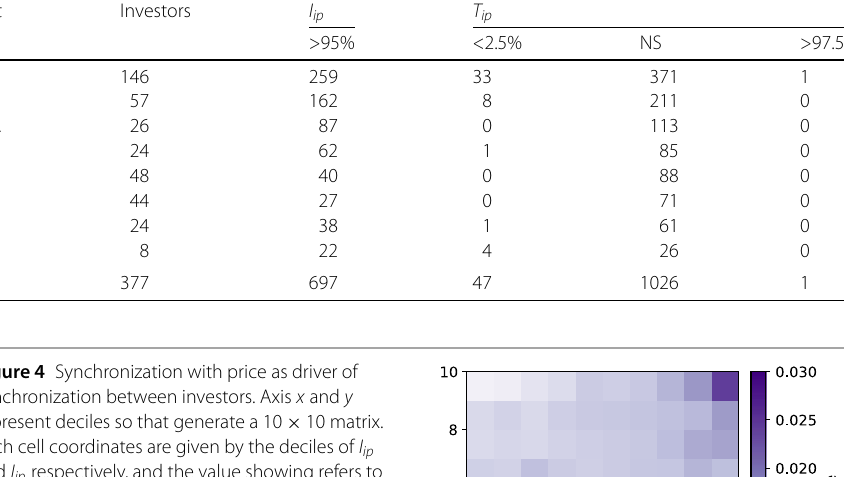
Table 3 Number of individuals with significant Symbolic Mutual Information (SMI) and Symbolic Transfer of Entropy (STE). The SMI I ip and STE T ip are calculated over the complete investor’s activity period A i in eight assets of the BME Spanish stock exchange. Significant values for SMI and STE are computed using the FDR approach described in the section “Methods”. Additional file 1 contains the same table but using the Bonferroni approach showing very similar results. First column gives the number of individuals with >95% confidence interval of sharing pattern with price evolution (among the total number individuals, in parenthesis). Three last columns present the equivalent analysis for STE. The number of individuals being in the <2.5% confidence interval are those showing a significant T ip < 0 (they are one-day delayed with respect to price change) while the number of in the >97.5% Confidence Interval are those with a significant T ip > 0 (they are anticipating price change). The column labelled as “NS” accounts for the number of individuals that do not present any significant STE between performance and price